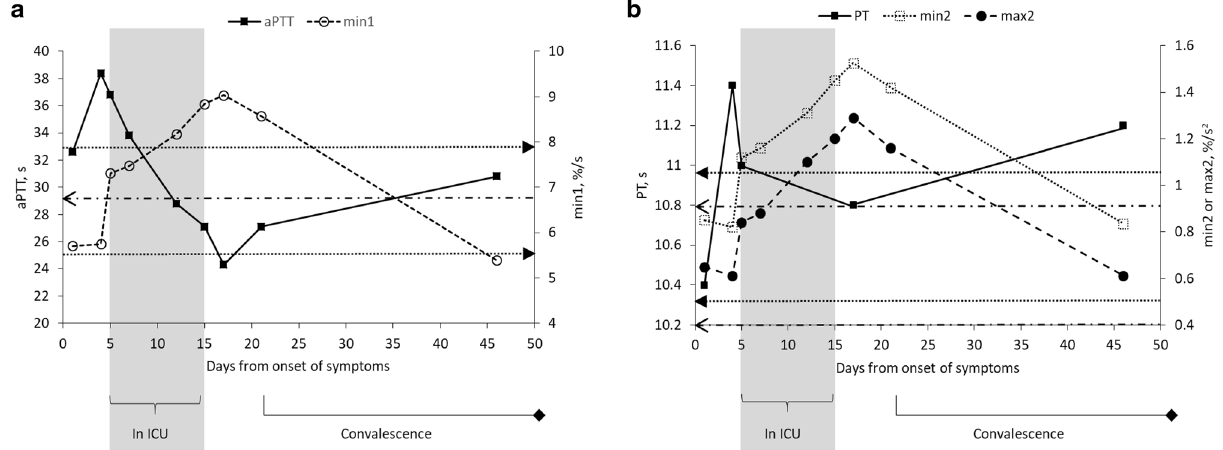
Figure 1. Dynamic changes of the serial haemostatic profiles of a COVID-19 patient from initial presentation to clinical deterioration* to subsequent recovery and convalescent phase. ( a ) Serial aPTT and min1 data of the patient. The horizontal dotted arrows ( ) depict the upper and lower limits of the reference intervals of aPTT while the horizontal dashed arrow ( ) shows the upper limit of min1 reference interval (min1 lower limit falls below the boundary of the graph shown). ( b ) Serial PT, min2 and max2 data of the patient. All the PT results fall within the reference intervals of 9.9 s to 11.4 s. The horizontal dashed arrows ( ) depict the upper and lower limits of the reference intervals of min2 while the horizontal dotted arrows ( ) show the upper and lower limits of max2 reference intervals. *Clinical deterioration defined as requiring intensive care unit (ICU) aPTT was shorter in convalescent phase, CWA profiles and PT were not significantly different between the two groups (Supplementary Table 1). (b) CWA parameters increased with clinical deterioration of COVID-19 (Table 3 and Fig. 1) Comparing the PT, aPTT and CWA data between COVID-19 patients with clinically mild disease and COVID-19 patients who required supplementary oxygen support, a surrogate of more severe disease, aPTT was significantly more prolonged and CWA parameters, especially min1, were significantly elevated in patients with severe disease. PT and D-dimer results did not differ significantly between the two groups. Serial PT, aPTT and CWA data depicting the various stages, from initial presentation through clinical dete- rioration to recovery and convalescence were available in one patient and the dynamic changes are shown in Fig. 1. Initial clinical deterioration was associated with prolongation of aPTT but aPTT normalised during the subsequent course of ICU stay and remained so at convalescent phase of COVID-19. However, min1 showed marked elevation upon ICU admission and continued to rise throughout the ICU stay despite normalisation of aPTT. Min1 only started to decrease at convalescence and eventual normalised on the 46th day from symptoms onset. Min2 and max2 demonstrated similar pattern of changes to min1 although the timing of their increment to